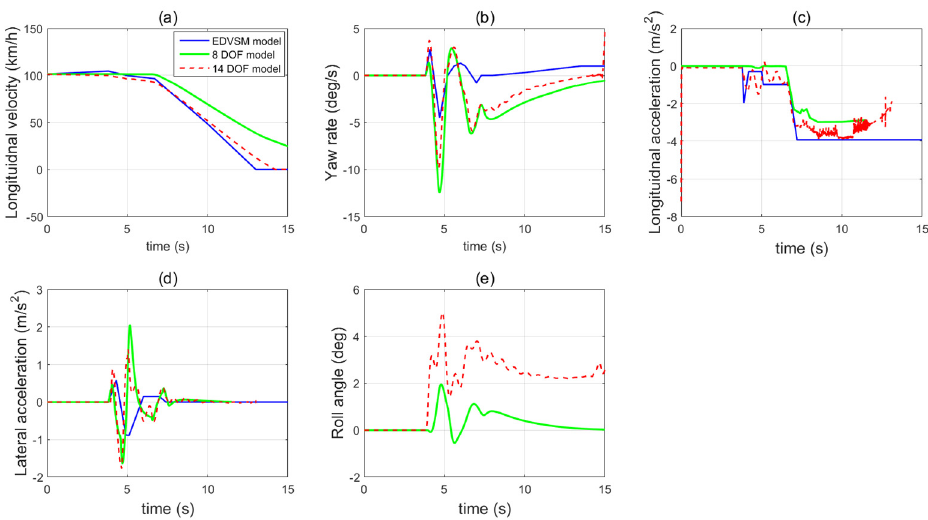
Figure 2. The vehicle state dynamics responses of 8 DOF model and 14 DOF model after tyre deflation ( a ) longitudinal velocity ( b ) yaw rate ( c ) longitudinal acceleration ( d ) lateral acceleration ( e ) roll angle.